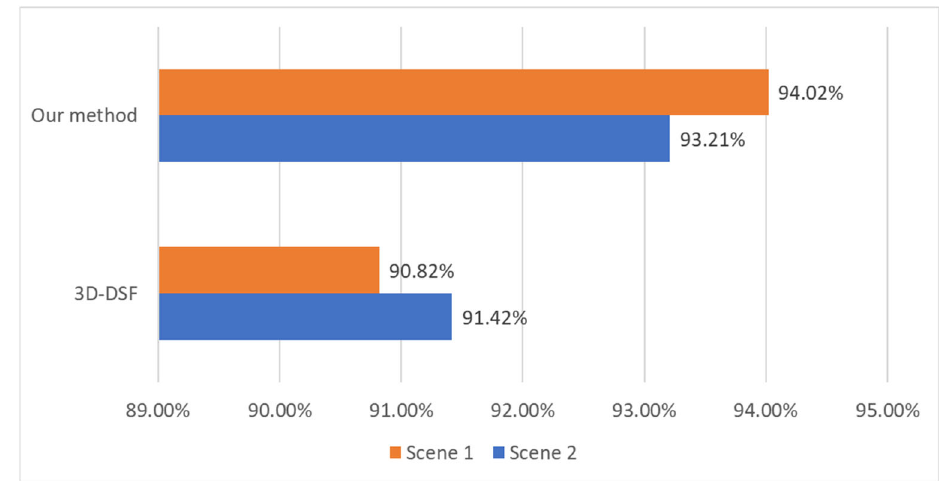
Figure 18. OA of two scenes using our method and 3D ‐ DSF at long distances.